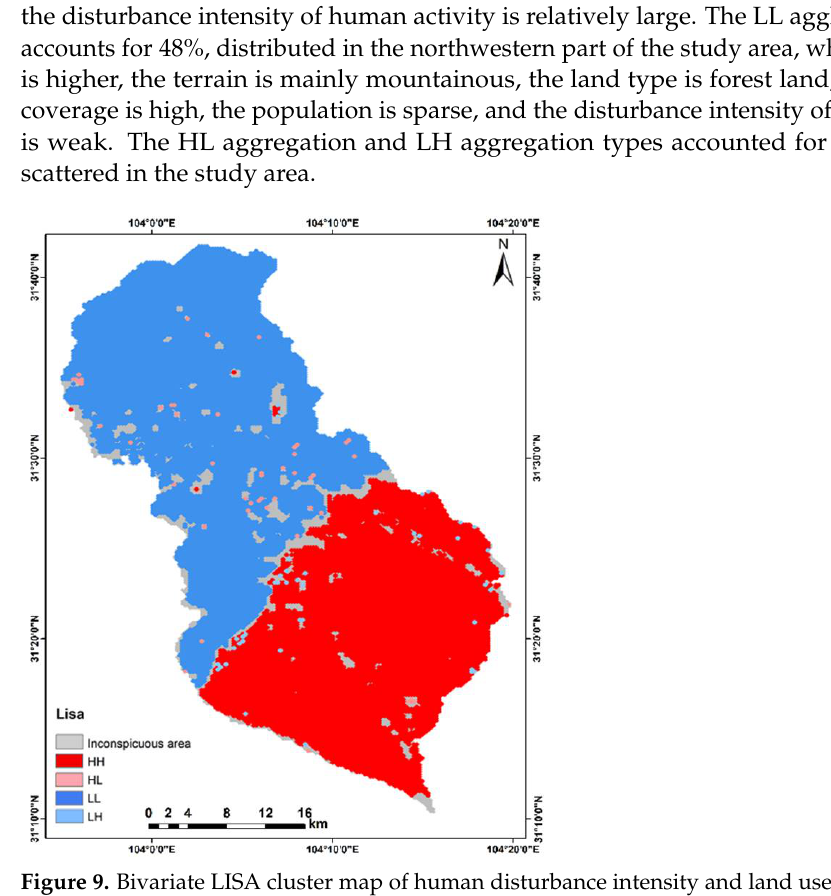
Figure 9. Bivariate LISA cluster map of human disturbance intensity and land use intensity.